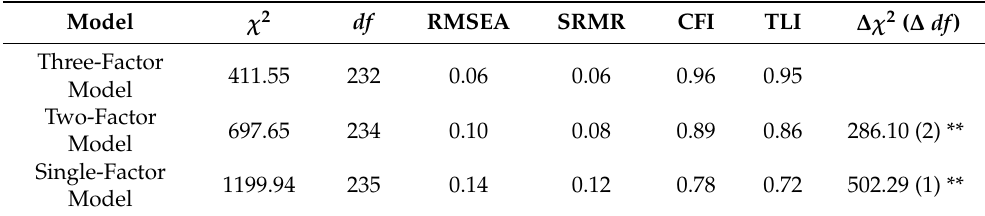
Table 2. Confirmatory Factor